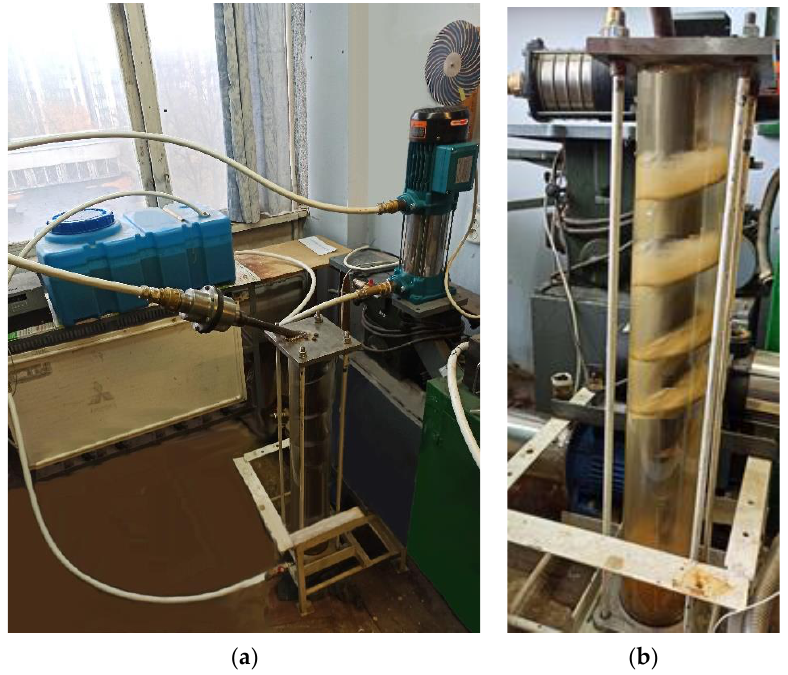
Figure 6. The experimental stand: ( a ) overview of the installation; ( b ) during the experiment.